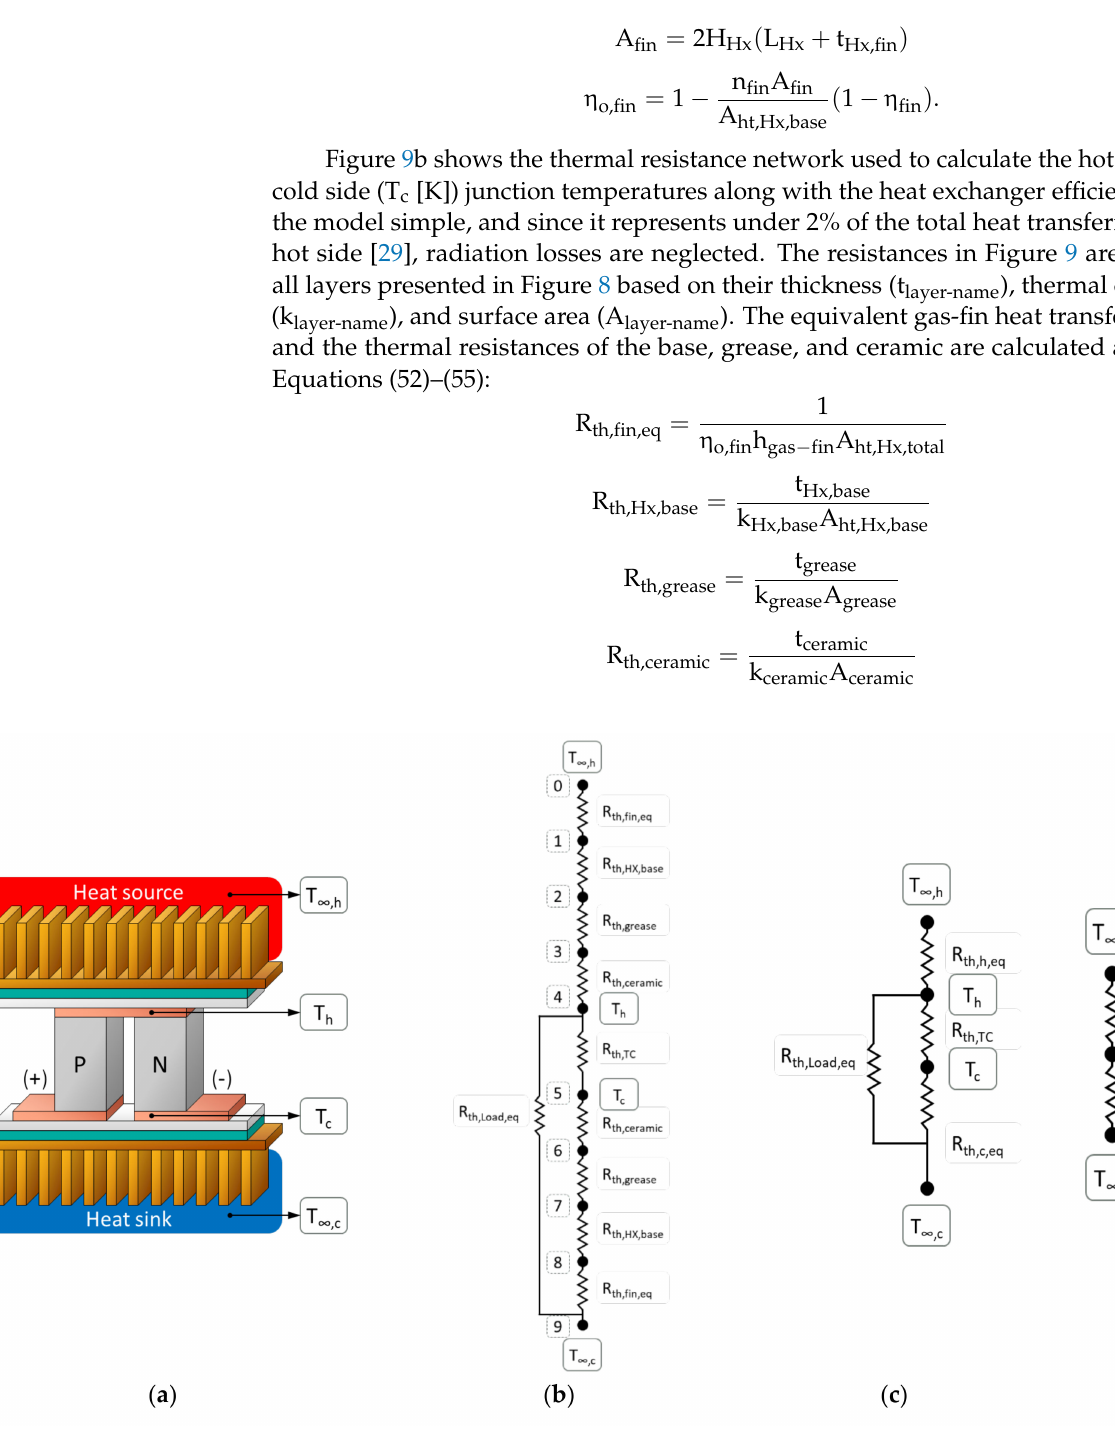
Figure 9. ( a ) Thermoelectric generator (TEG) temperatures of interest; ( b ) thermal resistance network for a CV; ( c ) simplified thermal resistance network for calculating T c ; and ( d ) simplified thermal resistance network for calculating T h